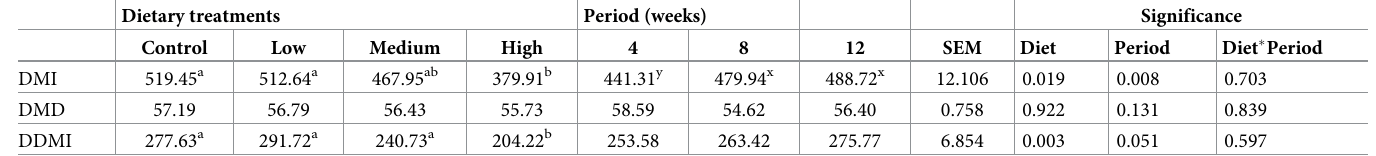
Table 4. Effects of increasing levels of lovastatin on dry matter intake (DMI, g/day), apparent total-tract dry matter digestibility (DMD, %) and digestible dry mat- ter intake (DDMI, g/day) in goats. Dietary treatments